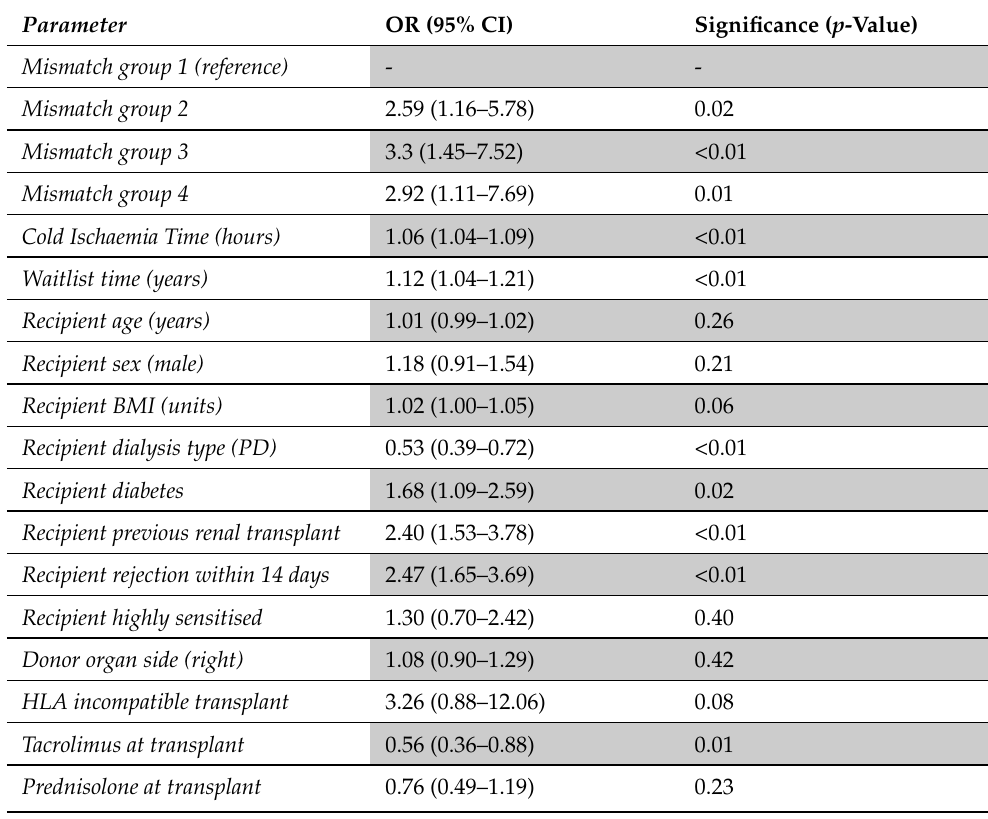
Table 2. Multivariate analysis—Odds of prolonged DGF (mismatch